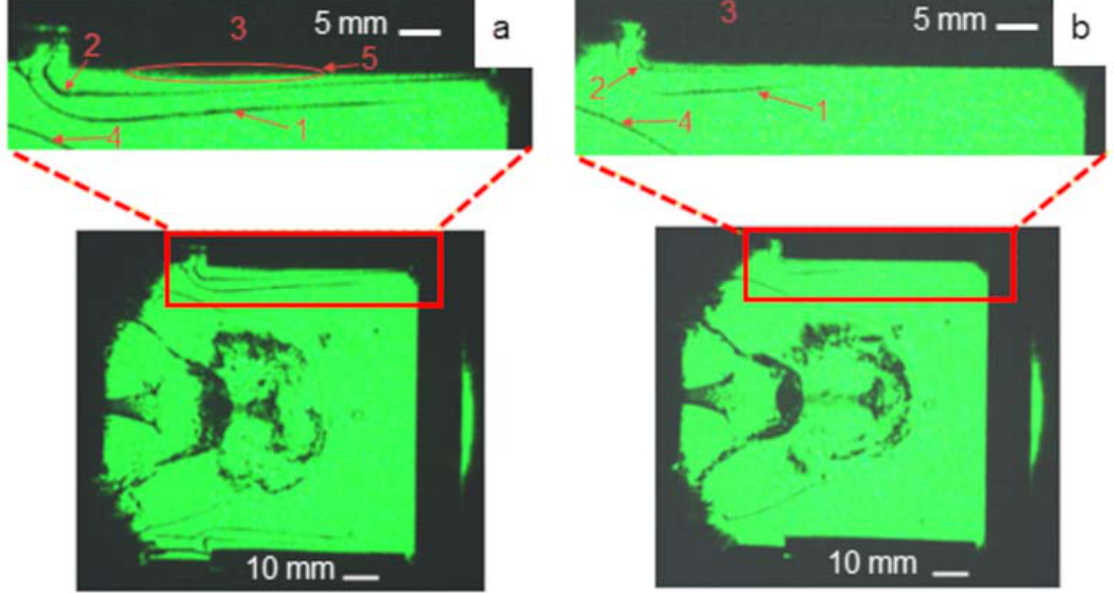
Figure 6. Schlieren images (at ≈ 11 µ s after switching) of MPC discharge and gas-dynamic structures above the sample PTFE surface for pure neon ( a ) and neon/air mixture ( b ): 1–shock wave front from PTFE, 2–contact boundary, 3–PTFE sample, 4–shock wave front from MPC and 5–dense vapors .